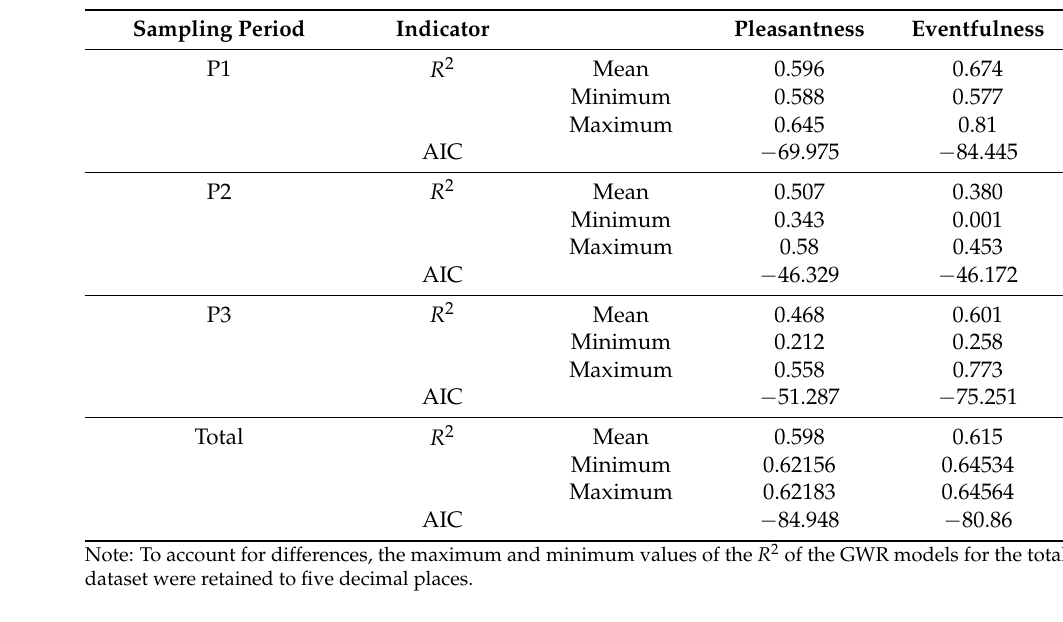
Table 5. R 2 and AIC of the GWR model.